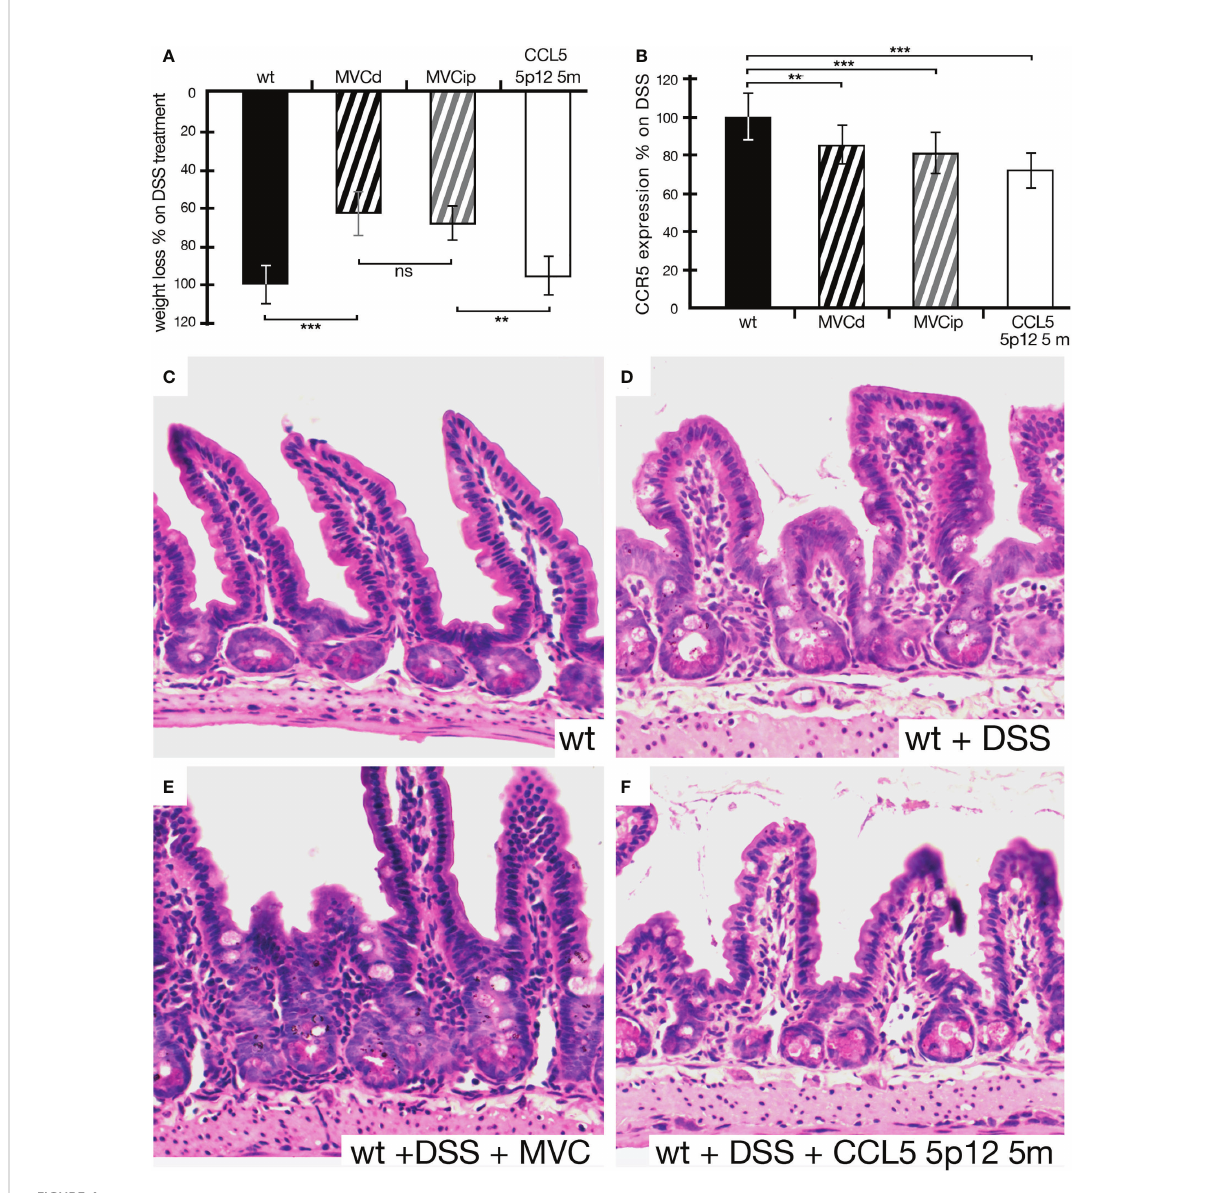
FIGURE 4 Weight loss of animals under DSS treatment being given MVC in drinking water, MVC i.p. or the CCR5 antagonist CCL5 5p12 5m. (A) As in Figure 3, the weight loss of wt animals under DSS treatment was set to − 100% (black histogram, control). Upon treatment with MVC either via drinking water (black striped histogram) or i.p. injection (gray striped histogram), the weight loss dropped to 66% (MVC in drinking water) and 81% (MVC i.p.), respectively, indicating that both methods of application were able to decrease weight loss in DSS-induced colitis compared to control. While the difference in MVC treatment (in drinking water as well as i.p. injection) was highly signi fi cant, i.p. treatment with CCR5 antagonist (white histogram) did not result in a reduction of weight loss as one of the hallmarks for colitis severity. (B) The number of cells positive for CCR5 in DSS-treated wt mice was set as 100% (black histogram, control). In DSS-treated wt animals that were additionally given MVC in drinking water (black striped histogram) or i.p. injected (gray striped histogram), the weight loss dropped to 85% (MVC in drinking water) and 81% (MVC i.p.), respectively, when compared to that of the control. Treatment with the CCR5 antagonist CCL5 5p12 5m had the strongest effect decreasing the value to 73% of the positive cells found in the control. (C – F) Representative captures of small intestine sections from wt (C) , DSS-treated wt (D) , wt treated with DSS + MVC (E) , and wt treated with MVC + CCL5 5p12 5m (F) . At least three animals and between fi ve and seven areas in at least three sections were used for determining the numbers for the graphs in (B) . **P < 0.01. and ***P <